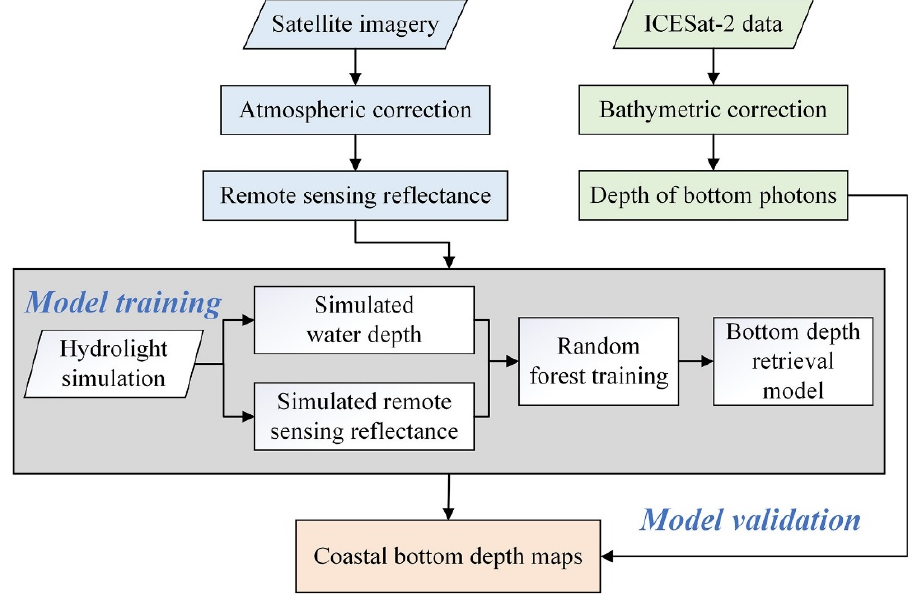
Figure 8. Flowchart of the satellite-based bottom depth retrieval process based on the established model built upon the simulation datasets. The ICESat-2 data can be further applied for model validation.